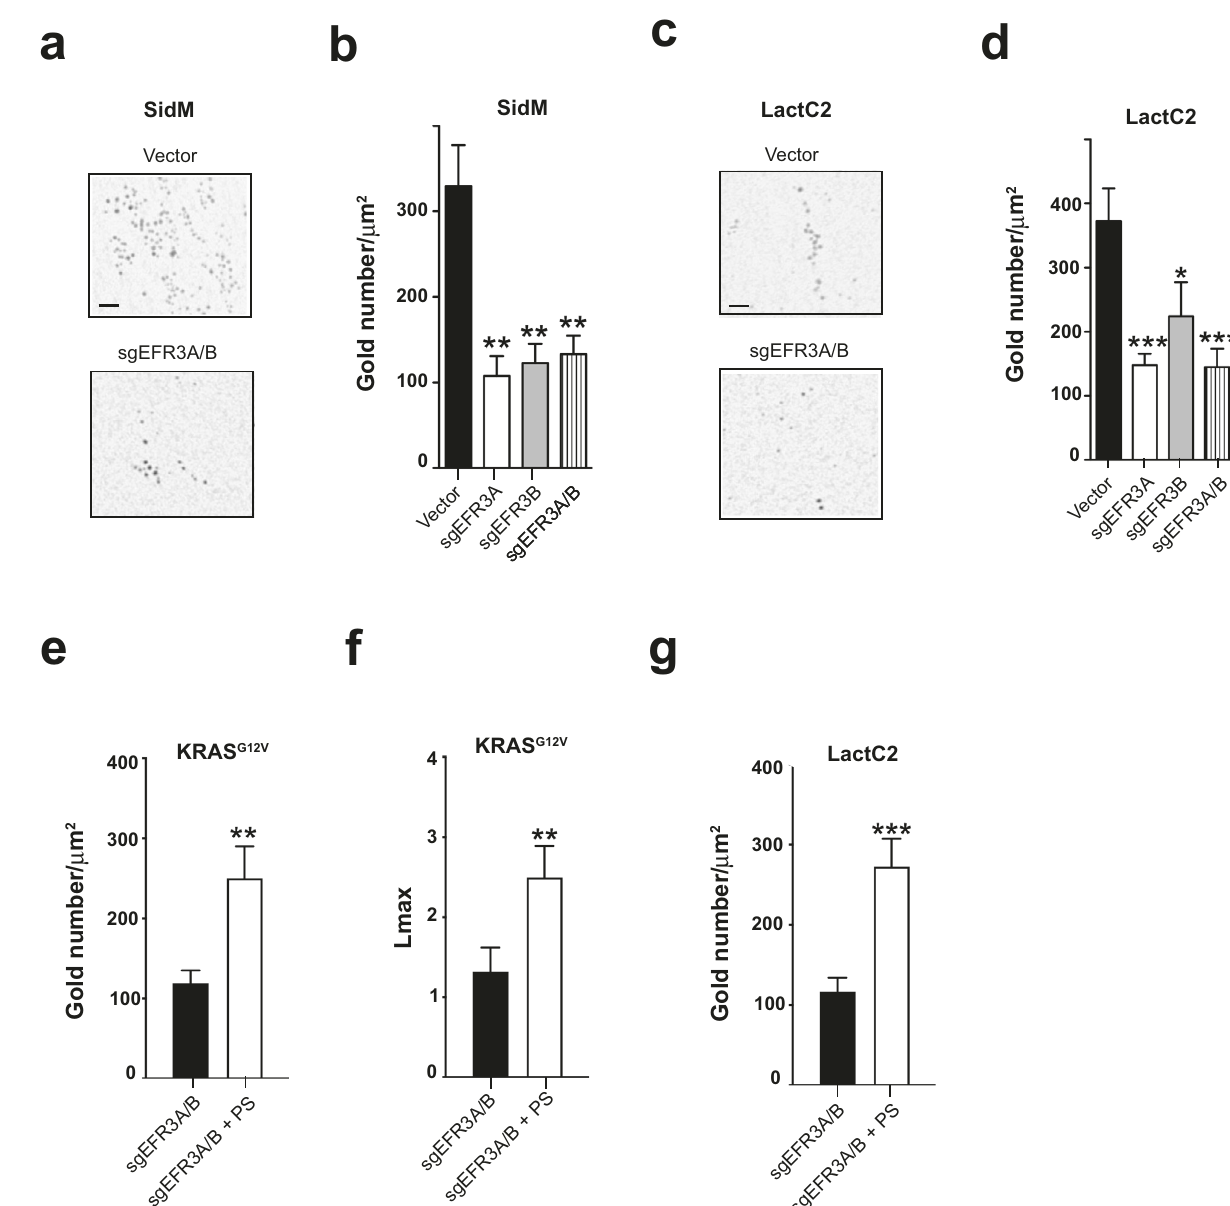
Fig. 8 EFR3A regulates plasma membrane lipid content to promote RAS oncogenesis. a , c Representative EM micrographs of plasma membrane (PM) sheets from human HEK-HT cells stably infected with a lentivirus(es) encoding Cas9 with no sgRNA (vector) or the indicated sgRNAs and transiently transfected with ( a ) GFP-P4M-SidM (a marker of PM PI(4)P) or ( c ) GFP-LactC2 (a marker of PM phosphatidylserine). Gold-conjugated GFP-antibodies seen as black dots are bound to the probe of interest. Scale bar: 100 nm. b , d The corresponding mean ± SEM of the number of gold particles per 1 μ m 2 of plasma membrane sheets representative of amount of ( b ) PI(4)P and ( d ) PS on the plasma membrane. e , f Mean ± SEM of ( e ) gold particles per 1 μ m 2 of plasma membrane sheets representative of the amount of KRAS on the plasma membrane and the ( f ) the extent of nanoclustering of KRAS on the plasma membrane as measured by Lmax from human HEK-HT cells transiently expressing GFP-KRAS G12V and stably infected with a lentiviruses encoding Cas9 and sgEFR3A/B in the absence and presence of exogenous phosphatidylserine (PS). g Mean ± SEM of gold particles per 1 μ m 2 of the plasma membrane sheets from human HEK-HT cells transiently transfected with GFP-LactC2 and stably infected with a lentiviruses encoding Cas9 and sgEFR3A/B in the absence and presence of exogenous phosphatidylserine (PS). a – g EM analysis is based on 30 images. Signi fi cance values were calculated by the two-sided bootstrap test for ( b , d – g ): * p < 0.05, ** p < 0.01, and *** p < 0.001. Speci fi c p values for ( b ) are 0.00062274 ( sgEFR3A) , 0.00111426 ( sgEFR3B) , 0.00167654 ( sgEFR3A/B) , d are 0.000436671 ( sgEFR3A ), 0.056486805 ( sgEFR3B ), 0.000536135 ( sgEFR3A/B ), e is 0.00680191 ( sgEFR3A/B + PS), f is 0.001 ( sgEFR3A/B + PS), and ( g ) is 0.00051866 ( sgEFR3A/B + EFR3A promotes KRAS oncogenesis through PI4KA . The complex with TTC7A or B and FAM126A in addition to PI4KA 28 . To therefore determine if PI4KA acts downstream of above fi ndings argue that EFR3A promotes oncogenic KRAS signaling and transformation by recruiting PI4KA to alter the EFR3A, we tested whether the loss of PI4KA affects oncogenic local lipid composition of the plasma membrane. EFR3A forms a KRAS signaling and transformation. To this end, KRAS -mutant